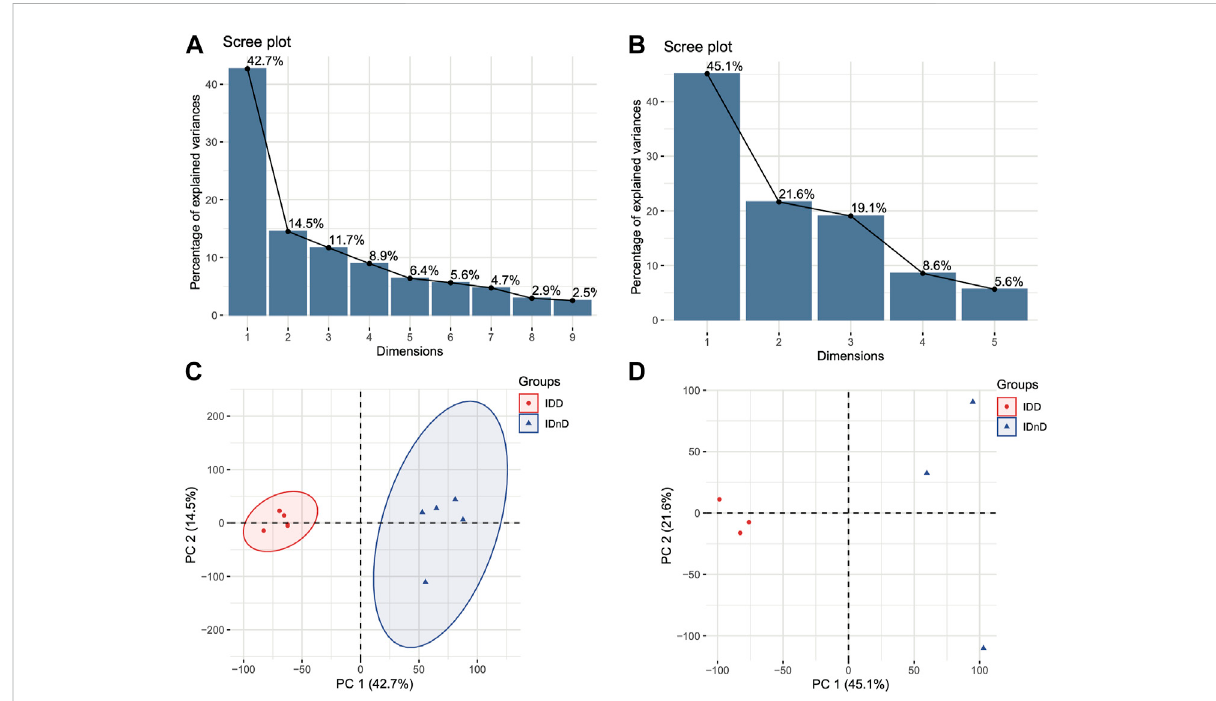
FIGURE 1 Different transcriptome expression patterns between IDD and IDnD. (A) Scree plot of the principal components in the GSE67567 dataset. (B) Scree plot of the principal components in the GSE167199 dataset. (C) PCA and clustering analysis in the GSE67567 dataset. (D) PCA and clustering analysis in the GSE167199 dataset. Axes are principal components 1 and